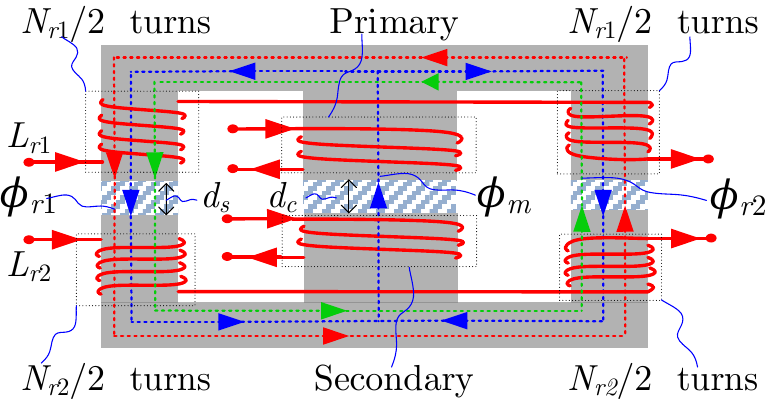
Figure 4. Magnetic flux analysis of the proposed integrated magnetics.